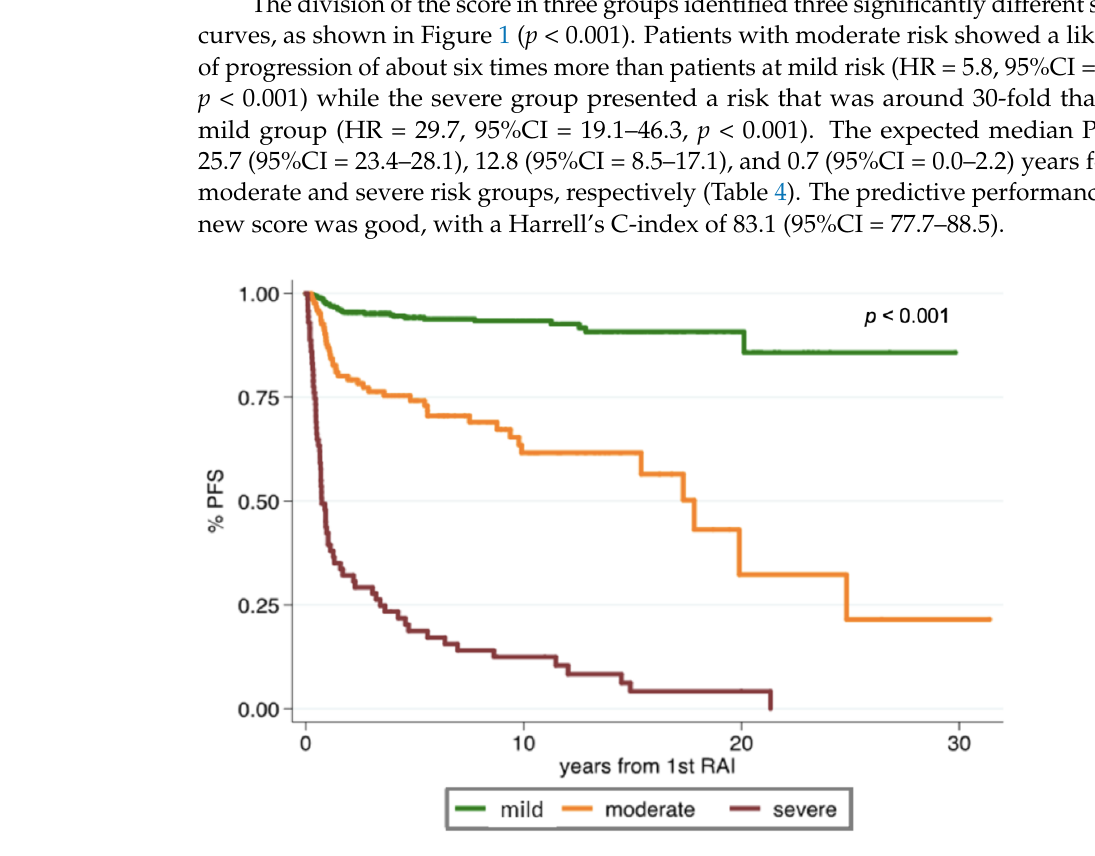
Figure 1. Kaplan – Meier curves of progression-free survival of the three-domain scoring system. Figure 1. Kaplan–Meier curves of progression-free survival of the three-domain scoring